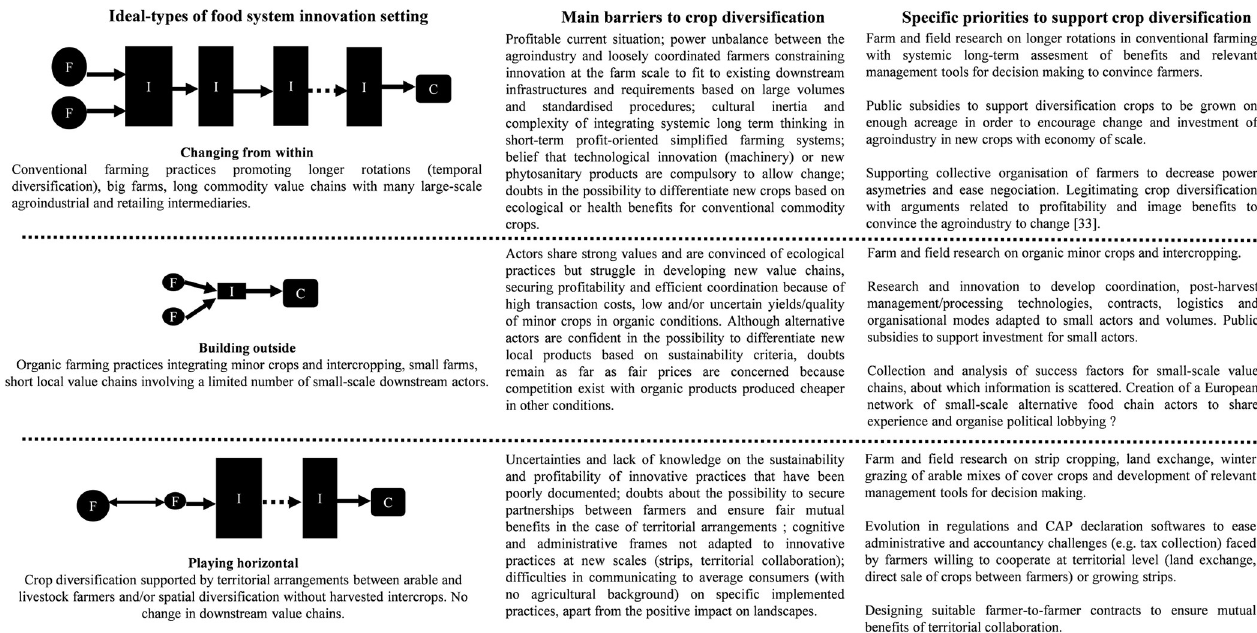
Fig 5. Main barriers and priorities to support crop diversification according to ideal-types of food system innovation setting. “F”: farmer”; “I”: intermediary actor of value chain (collector, processor, trader, retailer); “C”: consumer. Arrows represent the flows of products from production to consumption along the value chain. The size of value chain actors is in line with the average size of actors in the different ideal-types, which tended to be smaller in local and organic value chains.